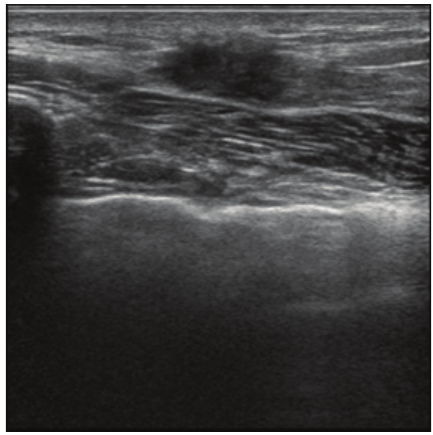
Figure 2: Ultrasonography revealed a hypoechoic lesion with an irregular margin and no acoustic shadow. The mass extended from the anterior border of the mammary gland.